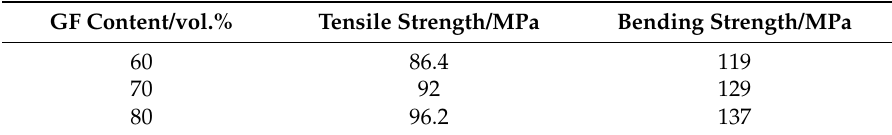
Table 4. Mechanical properties of the GF/PF/EP composites. GF Content/vol.%